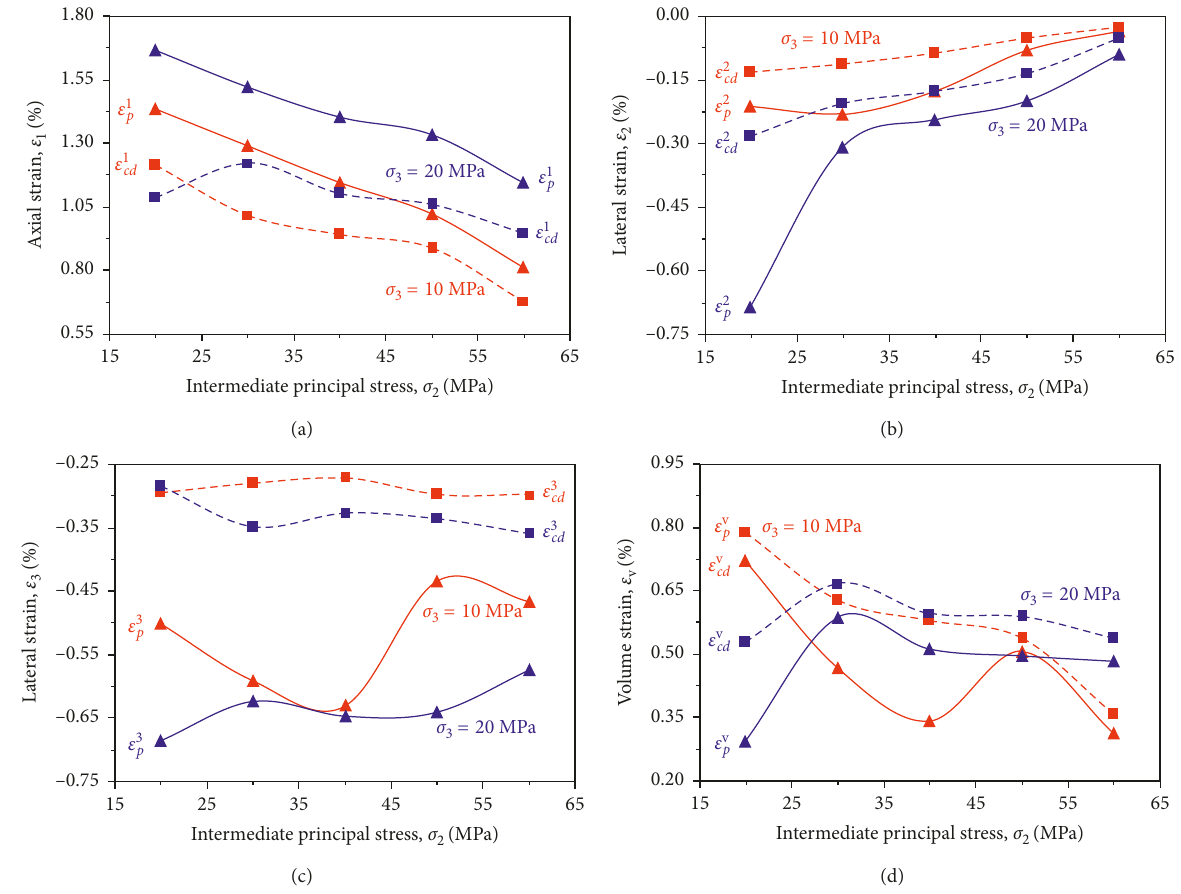
Figure 12: Strain characteristics of rock damage point and peak point under true triaxial compression: (a) axial strain; (b) lateral strain (the intermediate principal stress direction); (c) lateral strain (the minimum principal stress direction); (d) volumetric